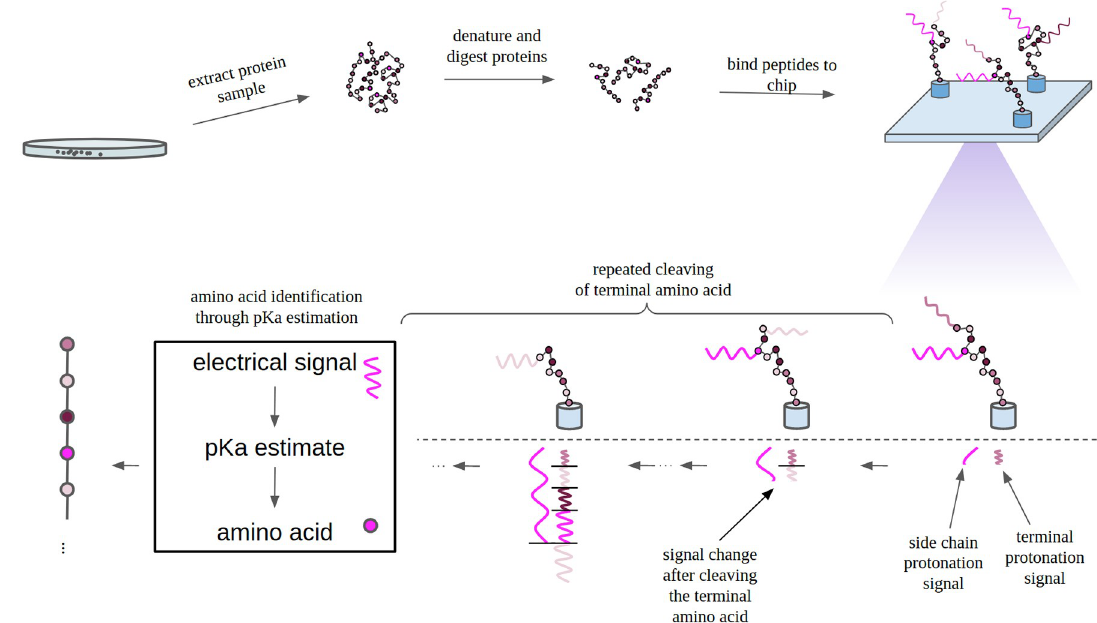
Fig 1. Protein sequencing based on reprotonation-deprotonation detection. Proteins are denatured and digested into peptides through the use of an endopeptidase. These peptides are anchored to a substrate, by either one of their terminal amino acids or by a cysteine. Changes in electrical charge due to the reprotonation-deprotonation of the free terminal amino acid are measured at this anchor point. These measurements provide information on the fraction of time the free terminal amino acid spends in a protonated state. In turn, this allows to determine the pKa value and hence identifies the amino acid. By repeatedly cleaving the terminal amino acid, each amino acid in the peptide can be identified in this way.